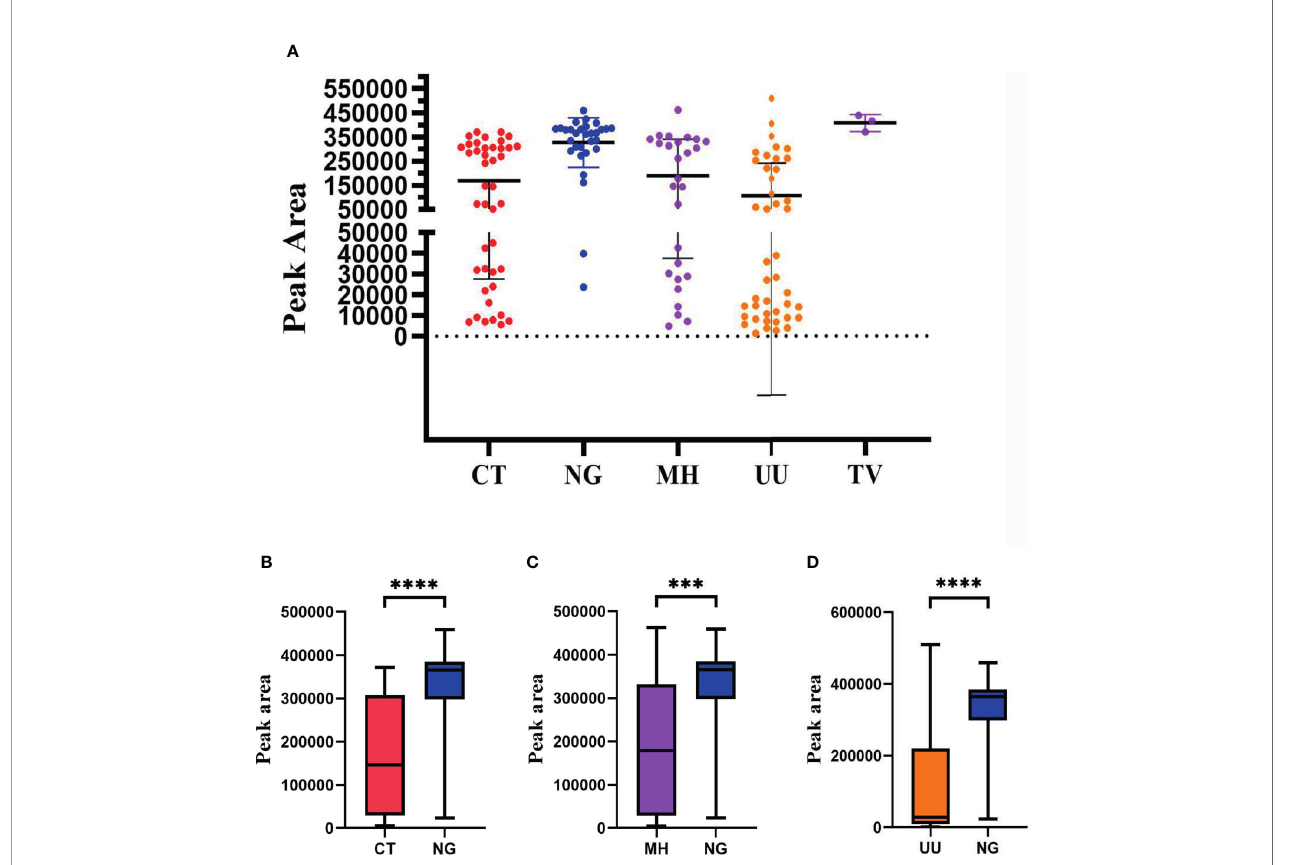
FIGURE 7 | The distribution of peak area values for each pathogen as determined by the Sexually transmitted infections high-throughput multiplex gene detection system (STI-HMGS) assay from the 123 positive clinical samples compared to pathogen loading. (A) The peak area values for each individual pathogen, which showed a wide distribution between 0 and 550000, varied across the different clinical samples. (B) The level of the peak area values for Neisseria gonorrhoeae ( NG ) were signi fi cantly higher than the level of Chlamydia trachomatis (CT). (C) The level of the peak area values for NG was signi fi cantly higher than the level of Mycoplasma hominis (MH). (D) The level of peak area values for NG were signi fi cantly higher than the level for Ureaplasma urealyticumm (UU). ***p < 0.001, ****p < 0.0001; p >